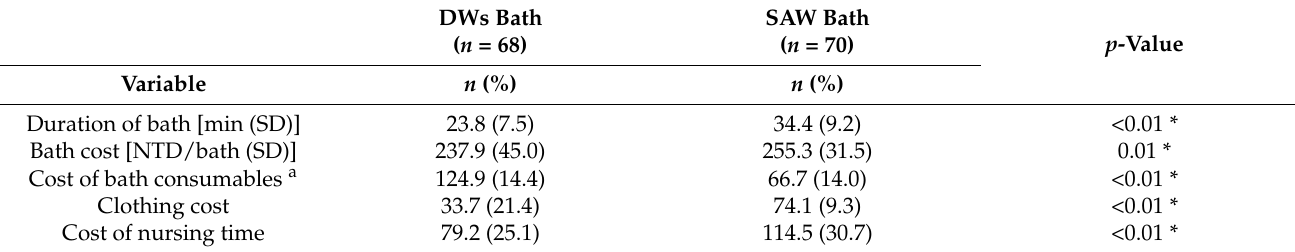
Table 2. Bath duration and costs of the two groups ( N =